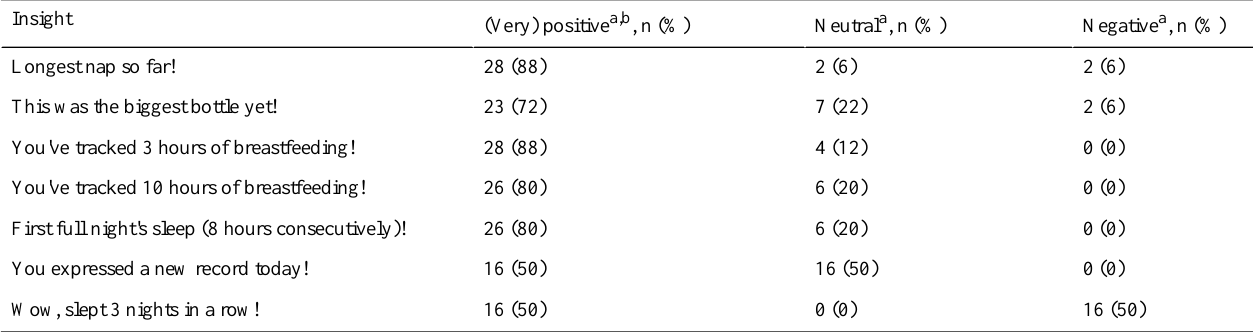
Table 2. Participants’evaluation of individual insights